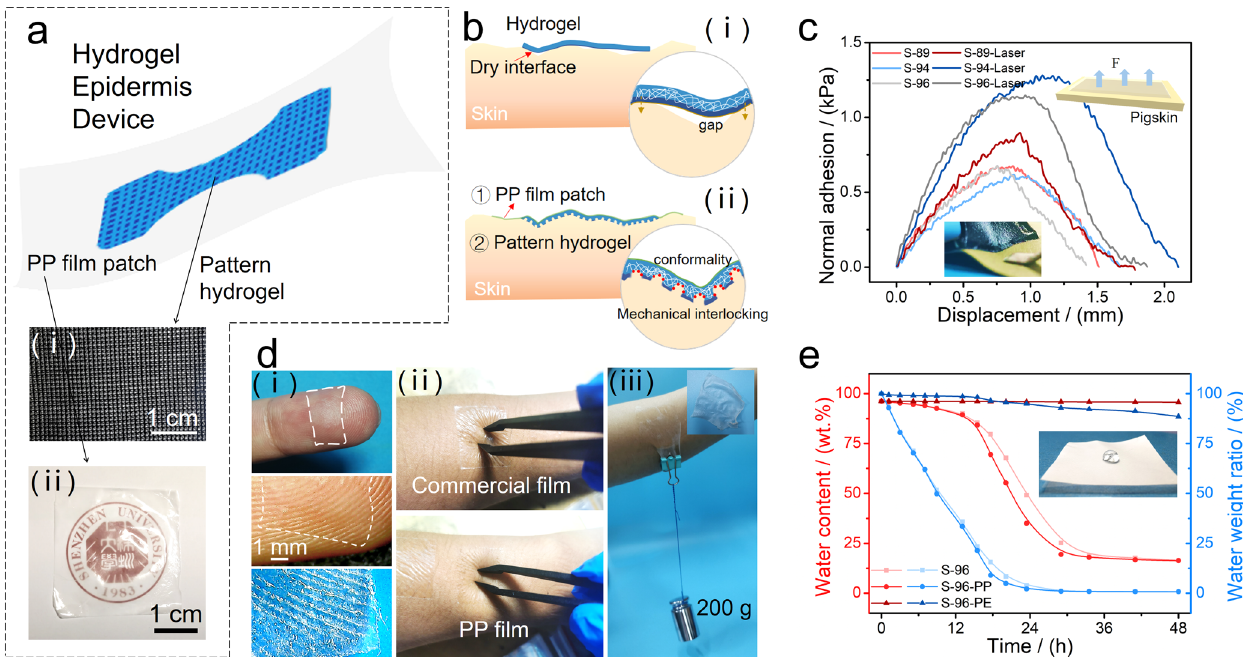
Fig. 4 Schematic illustrations and images of the skin-friendly PVA-S hydrogel and PP fi lm attached to the epidermis. a Schematic illustration of the epidermal device with (i) PVA-S hydrogel electrode and (ii) permeable fi lm. The selective laser engraving of a piece of PVA-S hydrogel to achieve patterns with processed micro-tips (300 μ m) surface. b The augmented bio-adhesive mechanism of the hydrogel micro- tips. c Representative adhesion-force pro fi les of PVA-S hydrogel attached to a pigskin substrate. Upper inset, schematic of the experimental set-up. Lower inset, photos of the peeling process of a PVA-S hydrogel anchored on a leather. d (i) Pictures of a PP fi lm conformally attached to a fi ngertip. (ii) The PP fi lm on skin compared with a commercial patch under press state. (iii) The demonstration of a PP fi lm (4 cm × 4 cm) fully supporting a 200 g mass on skin. e Water vapor permeability of the S-96 hydrogels, S-96 with PP fi lm, and referential S-96 with plastic wrap (PE fi lm) as a function of time. Inset digital images describe the hydrophobic external surface properties of the PP fi